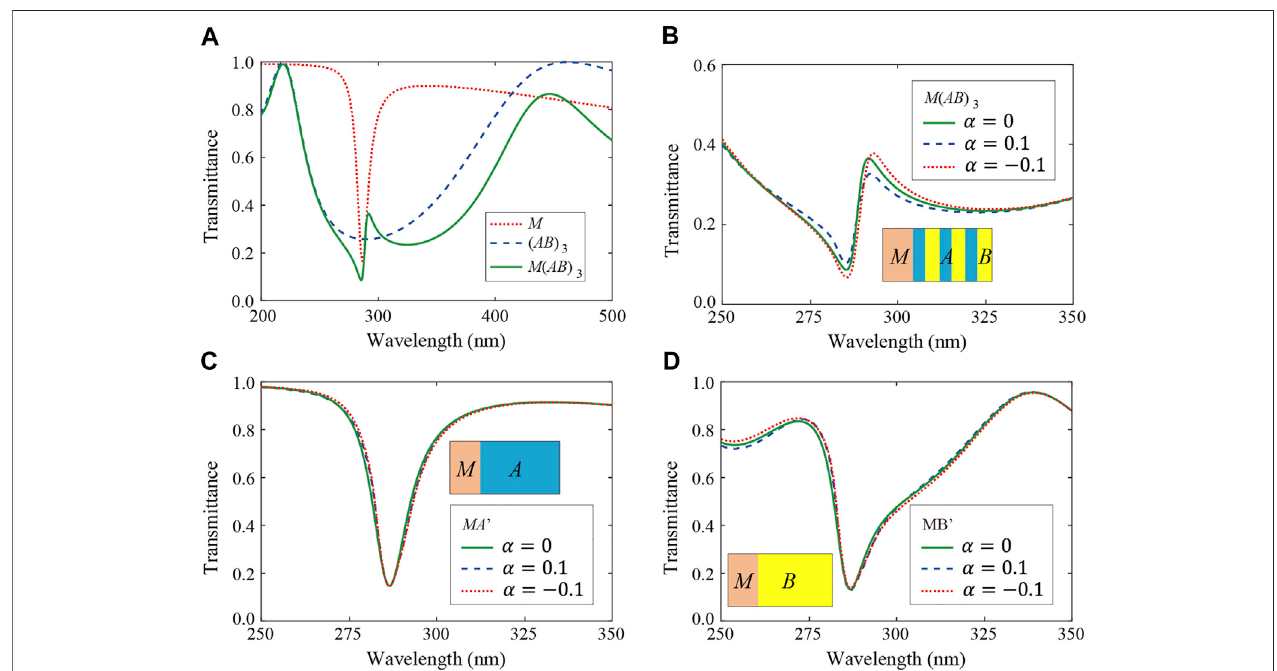
FIGURE 2 | (A) Transmittance spectrum of single M layer, the 1DPC: ( AB ) 3 , and their composite structure M ( AB ) 3 without external magnetic fi eld α = 0, which corresponds to the dotted red line, dashed blue line, and solid green line, respectively. Here, d A = 70 nm, d B = 25 nm, d M = 10 nm, and θ = 50 ° . (B) The transmittance spectrumofthecomposite structure M ( AB ) 3 fordifferentMOcoef fi cient: α =0(solidgreenline), α =0.1(dashedblue line),and α = − 0.1(dotted redline),respectively. (C, D) Similar to (B) , but for the heterostructures MA and MB , respectively. The thickness oflayer A in (C) [ B in (D) ] 285 nm, which is the same as the total thickness of 1DPC: ( AB ) 3 in (B) . Inset fi gures in (B – D) show the schematic of corresponding